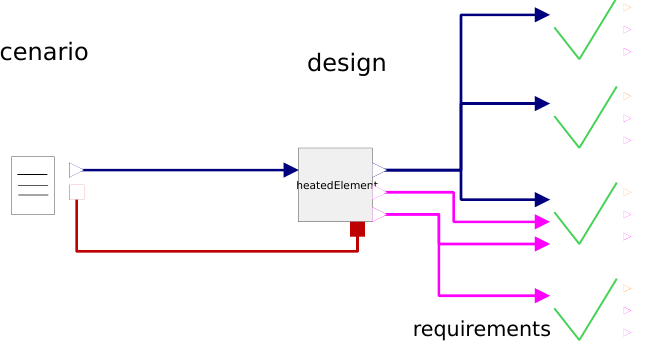
Figure 8. An example of a verification model with a sunny day scenario, the design alternative, and four requirements.